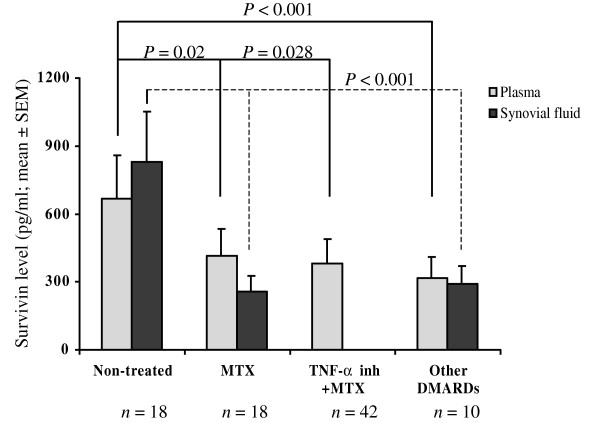
Influence of disease-modifying anti-rheumatic drugs on survivin levels of rheumatoid arthritis patients with erosive joint disease. DMARDs, disease modifying anti-rheumatic drugs; MTX, methotrexate; TNF-α inh, tumour necrosis factor alpha inhibitors; SEM, standard error of the mean.